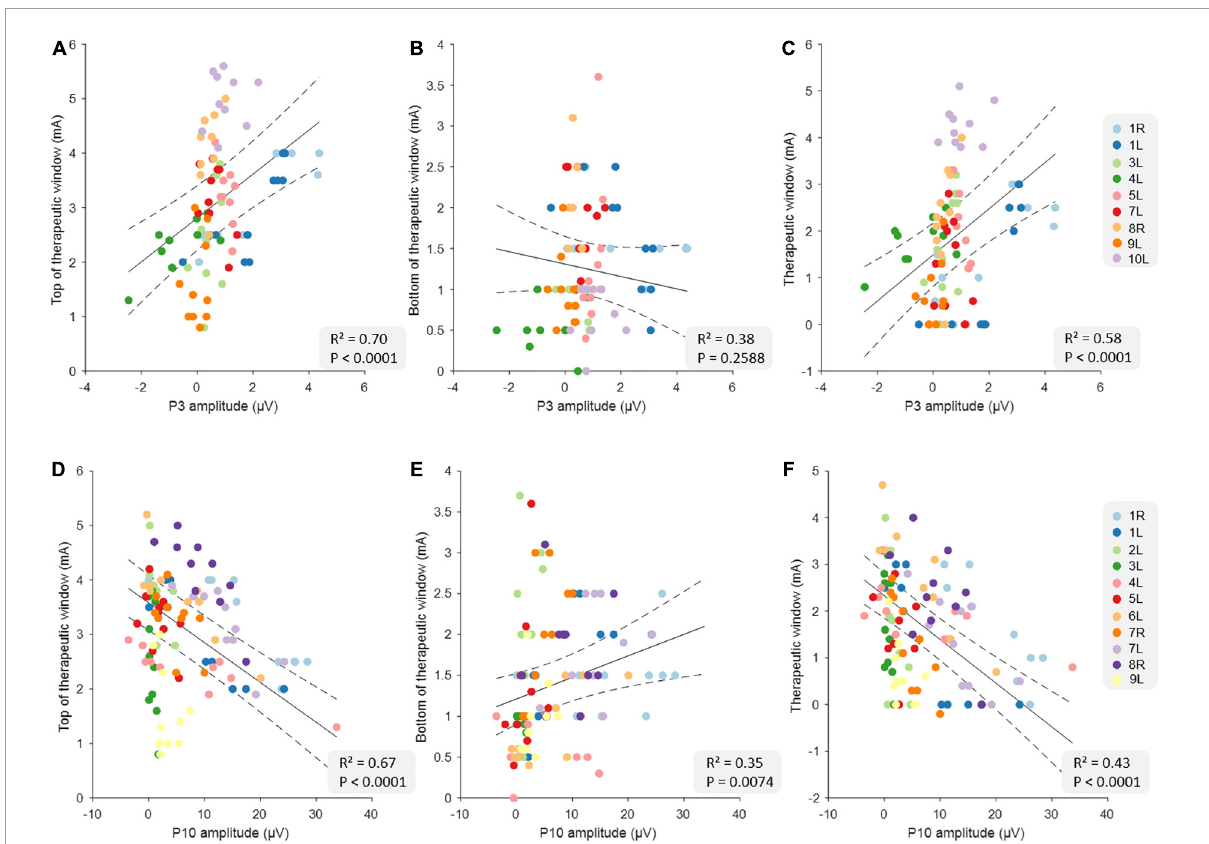
FIGURE1 Relationship between clinical measures and the evoked potential (EP) amplitudes at the group level. The top row illustrates the relationships between top of therapeutic window (tTW) (A) , bottom of therapeutic window (bTW) (B), and therapeutic window (TW) (C) and P3 amplitude at the group level ( n = 90). The bottom row illustrates the relationship between tTW (D) , bTW (E) , and TW (F) and P10 amplitude at the group level ( n = 110). The colors indicate the 10 deep brain stimulation (DBS)-contacts (i.e., eight individual contacts and two segmented contact levels in ring mode) of the different hemispheres as is shown on the legend on the right side of each row. The black lines indicate the slope of the linear mixed models with CI (dashed